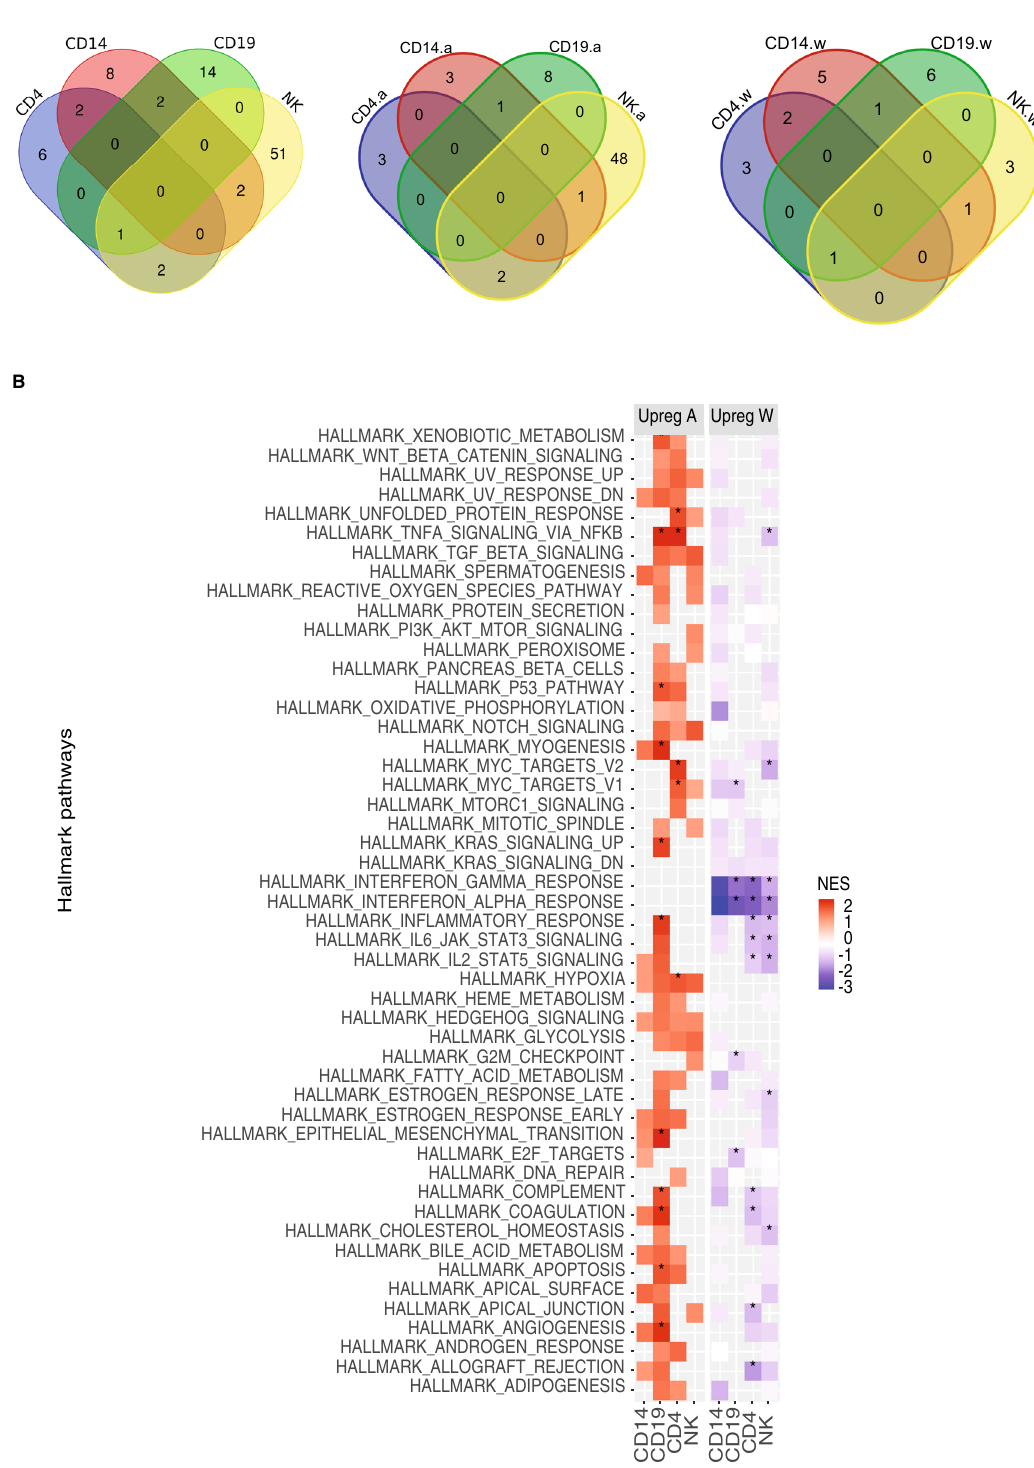
Fig. 3 Differential gene expression analyses. A Identi fi cation of the common DE genes (padj < 0.05 and abs log2FC> 1) White vs. Asian cohorts across the different cell types. Supplementary Data 2a, b, and 2c list the genes shared and speci fi c for each cell type. B Pathway enrichment analyses for the associated genes in White vs. Asian